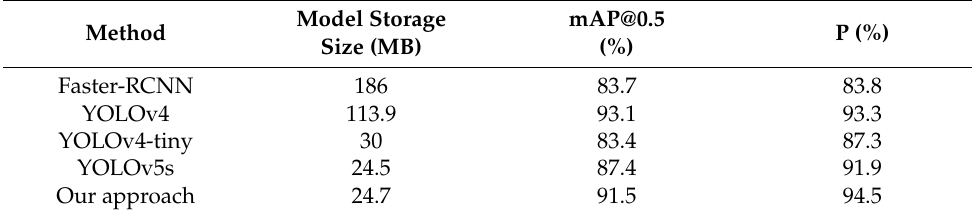
Table 7. Performance comparison of different detection